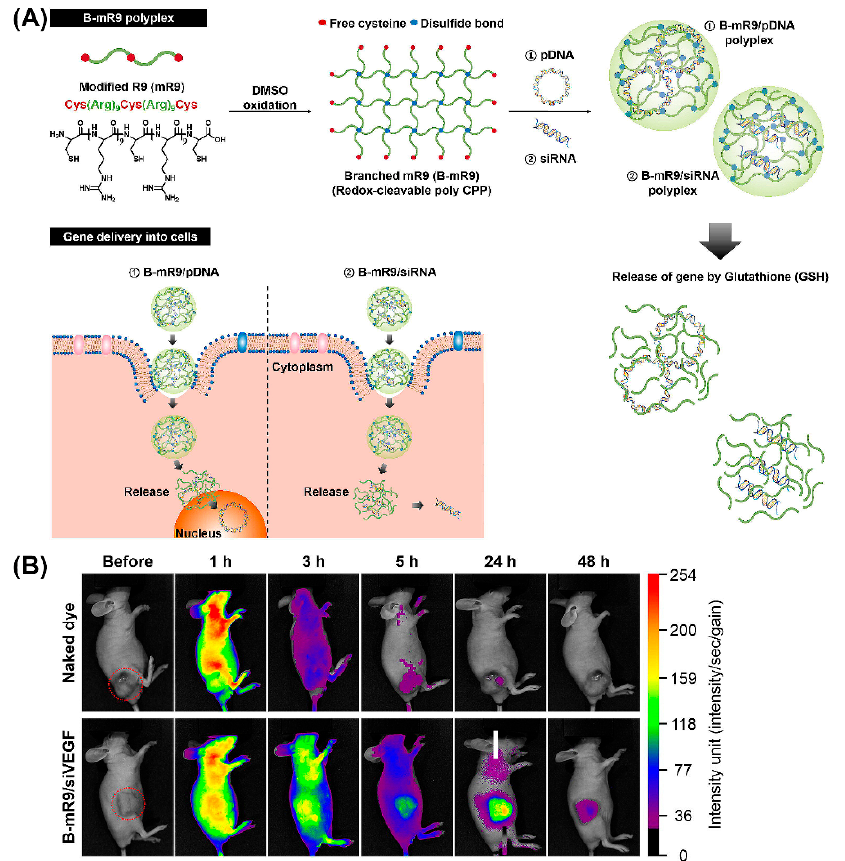
Figure 11. ( A ) Schematic illustration of synthesis of the branched modified R9 (B-mR9) CPP and construction of pDNA and siRNA polyplexes. Positively charged B-mR9 can be complexed with negatively charged genes through electrostatic interactions. B-mR9 polyplexes were delivered into cells by means of CPP-mediated permeabilization. The branched structures of B-mR9 were then cleaved by the reductive conditions of the cytoplasm. Finally, pDNA or siRNA was released into the nucleus or cytoplasm, respectively. ( B ) Naked dye and B-mR9 / siVEGF polyplexes were intravenously injected into NCI-H460 tumor-bearing mice and the biodistribution was observed over 48 h. Adapted and modified from [148], with permission. Copyright: 2017 Elsevier.